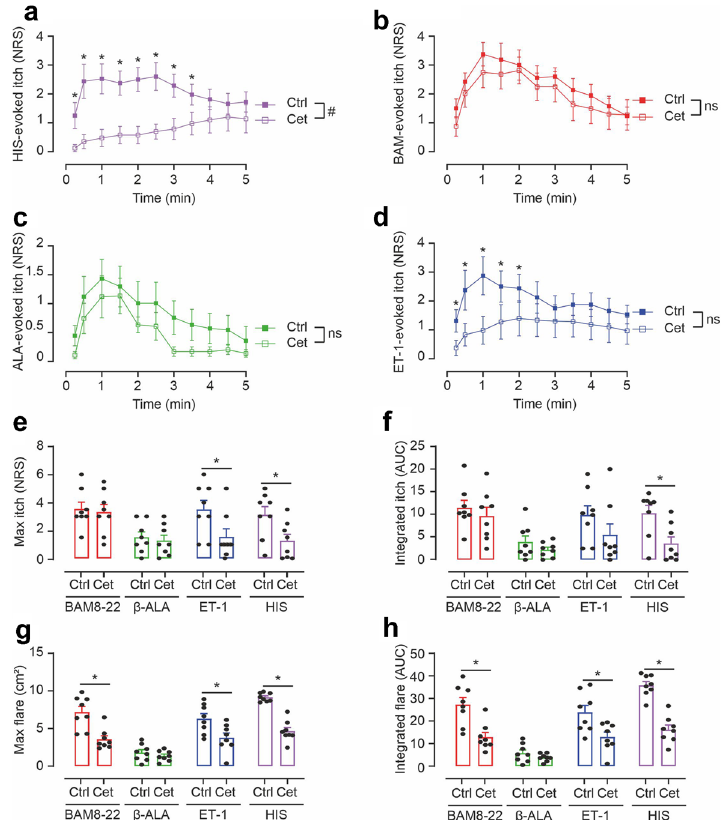
Figure 2. BAM8–22, β-ALA, and ET-1 evoke somatosensory and vascular responses via HIS-dependent and HIS-independent mechanisms. ( a–d ) Itch recorded on a numeric rating scale (NRS, 0–10) for 5 min after pruritogen delivery in 8 subjects before (Ctrl, solid symbols) and 3 h after oral HRH1-antagonist cetirizine (Cet, open symbols). Cet treatment diminished ET-1-evoked itch at early time-points (p < 0.05, marked with asterisk), whereas HIS-induced itch was decreased overall (p < 0.01, marked with hash sign) and in particular at early time-points during the 5-min observation period (p < 0.05, marked with asterisks). Note that Cet had no effect on BAM8–22- and β-ALA-evoked itch (n.s.). Data are shown as mean ± standard error (SEM). ( e,f ) Group comparison of maximum itch (NRS) and integrated itch (AUC) evoked by the pruritogens before (Ctrl) and 3 h after cetirizine (Cet). Maximum itch upon ET-1 and HIS as well as integrated itch after HIS delivery were significantly reduced by Cet (p < 0.02, marked with asterisks) whereas responses to BAM8–22 and β-ALA were not affected. Data are shown as mean ± standard error (SEM) with overlay of individual data points. ( g,h ) Maximum flare (cm 2 ) and integrated flare (AUC) recorded during 5 min after pruritogen administration before (Ctrl) and after cetirizine (Cet). Maximum and integrated flare responses upon BAM8–22, ET-1, and HIS challenge were significantly attenuated by Cet (all p < 0.0001, marked with asterisks). Data are shown as mean ± standard error (SEM) with overlay of individual data points.